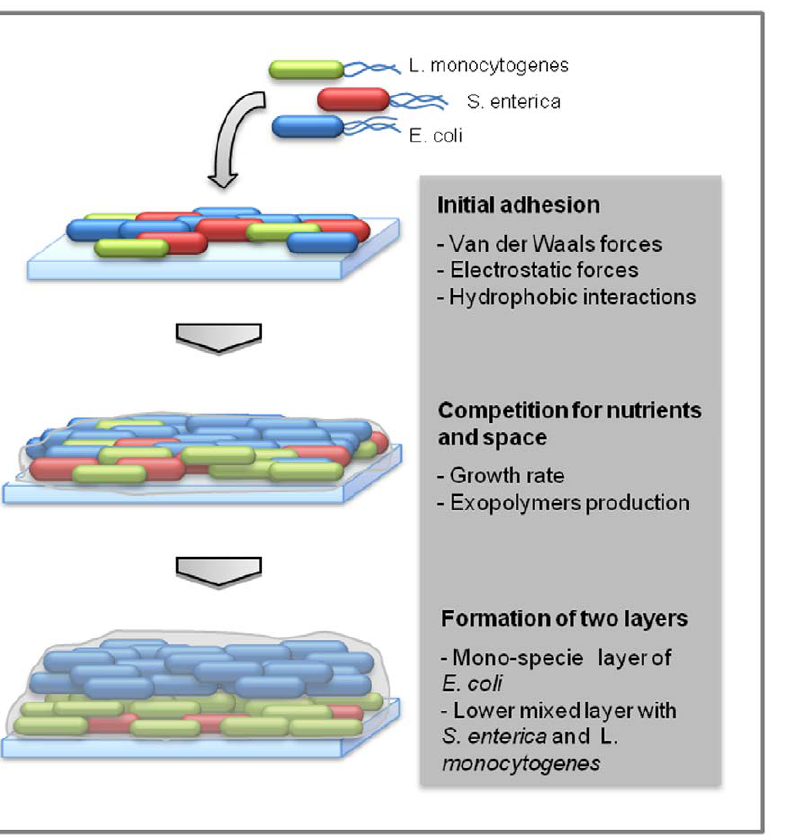
Figure 8. Schematic representation of the tri-species biofilm formation showing the main steps and the key factors involved on the two layers appearing.